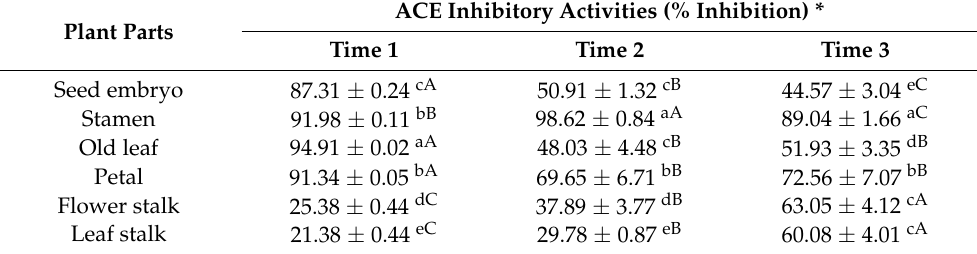
Table 7. Angiotensin-converting enzyme (ACE) inhibitory activities of different sacred lotus parts collected from different time periods.